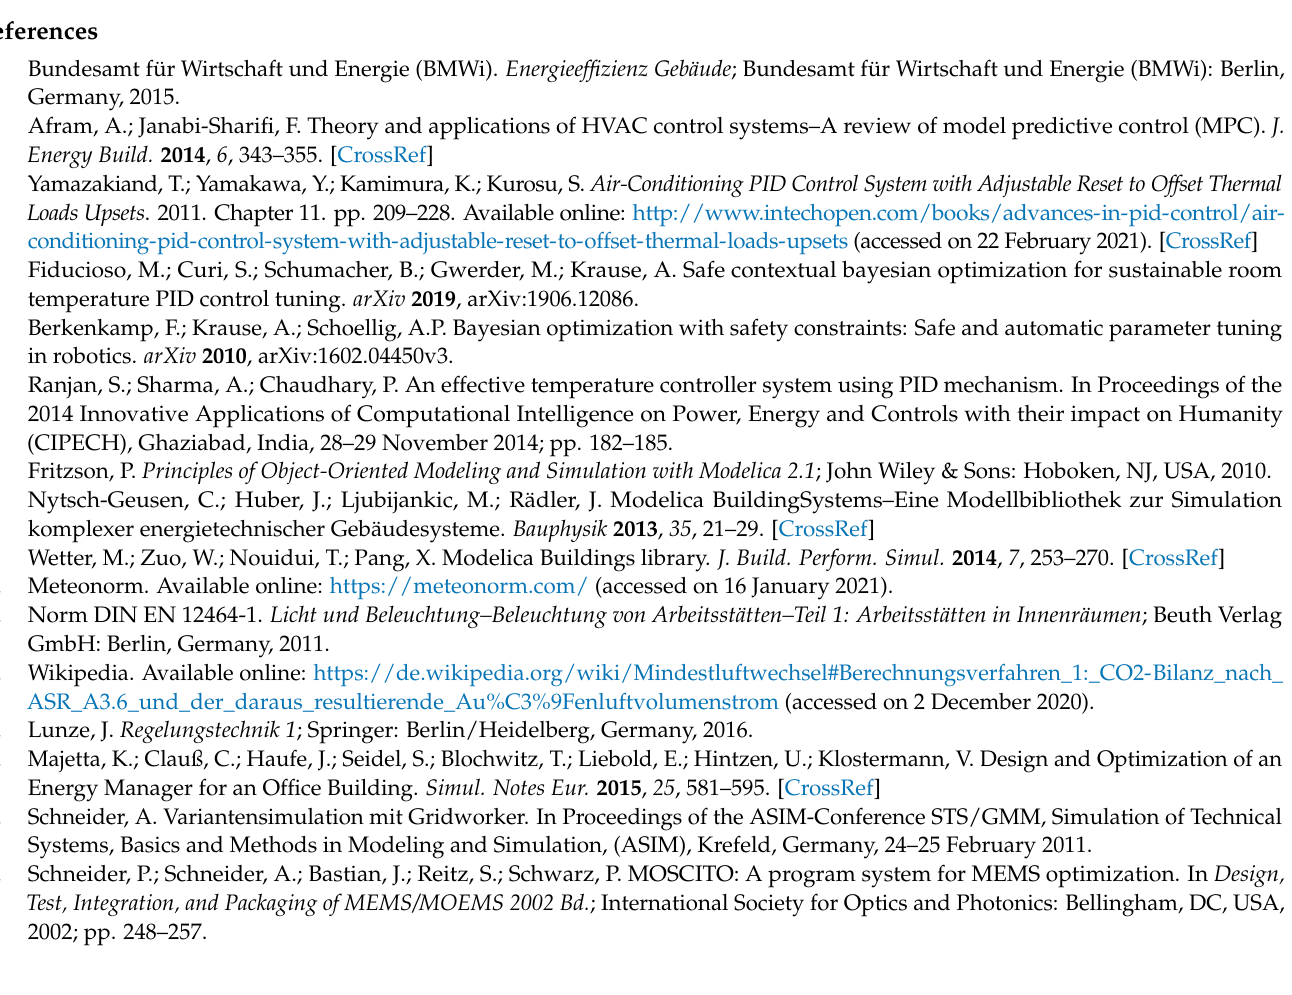
two-point controller, Figure S11: Optimal controller parameter k of p-controller, Figure S12: Optimal controller parameter p1 of predictive controller, Figure S13: Optimal controller parameter p2 of predictive